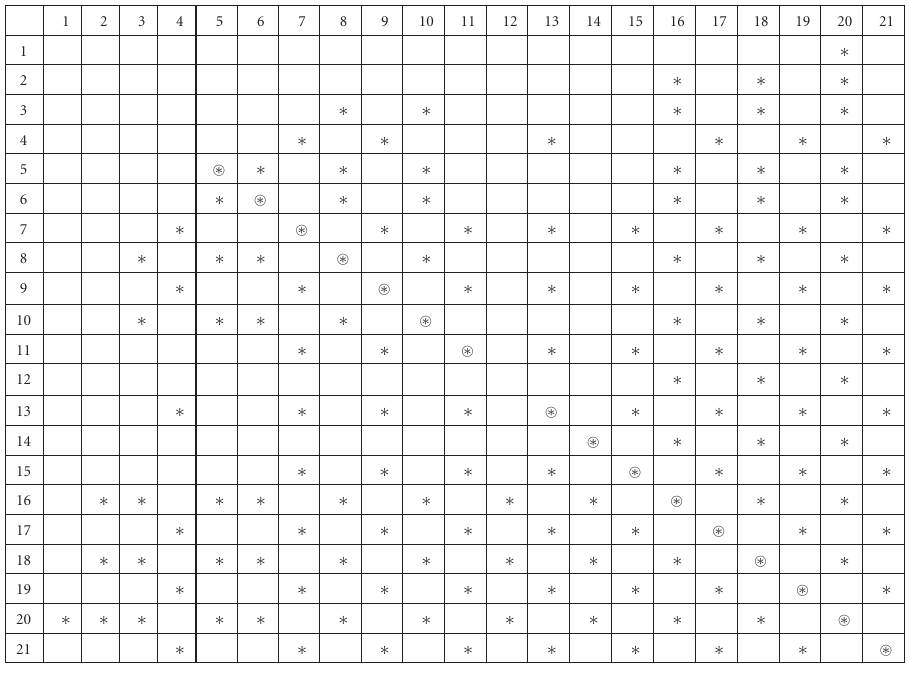
Table 2.1. Kneading data for bimodal maps (detail). For the lines of the table, we have 1 − RLLA